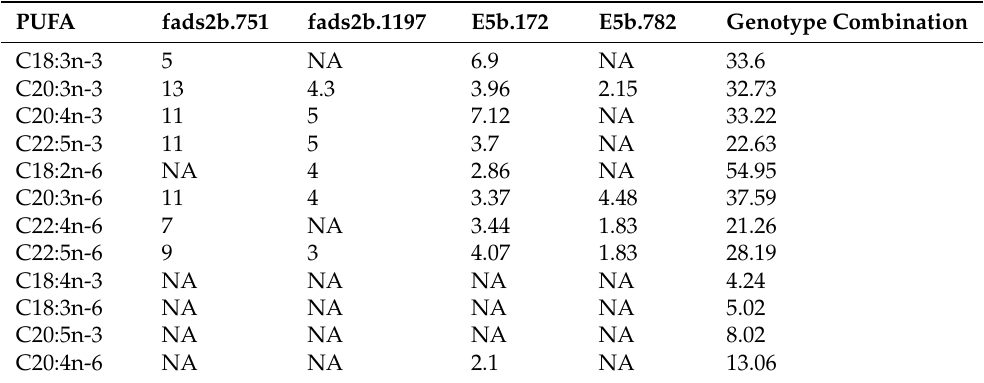
Table 3. The explained percentage of PV for each PUFA by each genotype combination from four SNP loci in fads2b and elovl5b across 223